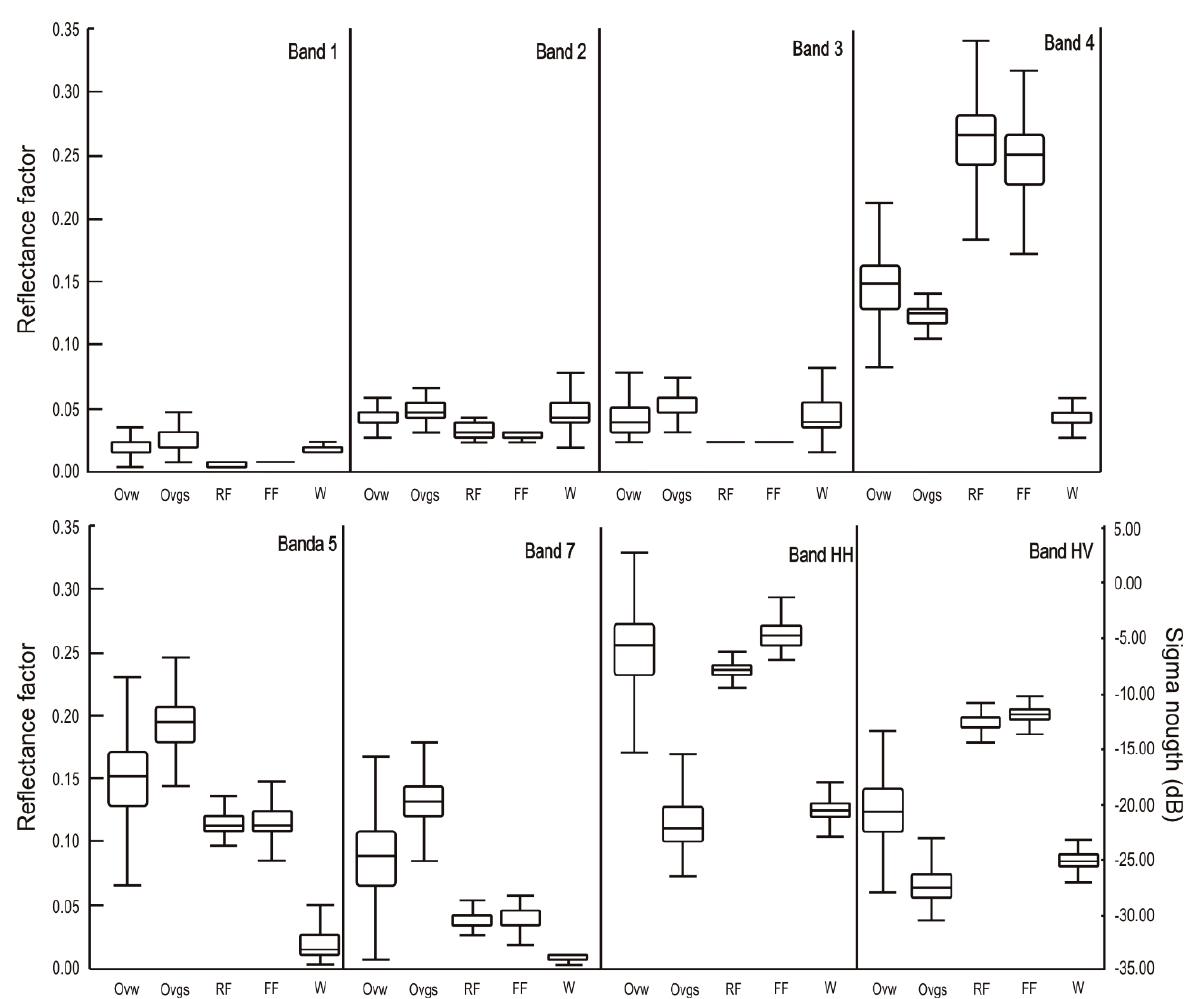
Figure 4. Box-plots representing variation in reflectance and sigma nought for the training